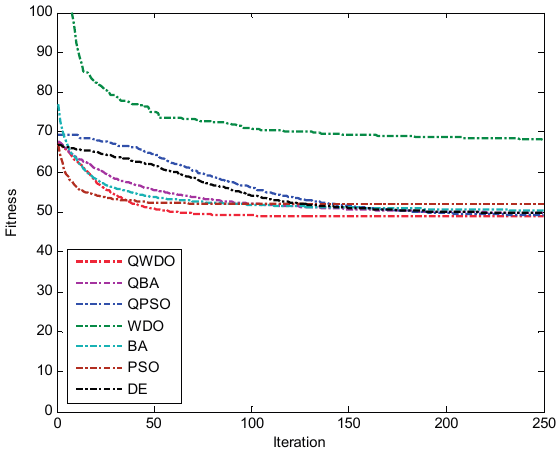
Figure 22. Fitness of the second instance for Maxgen =